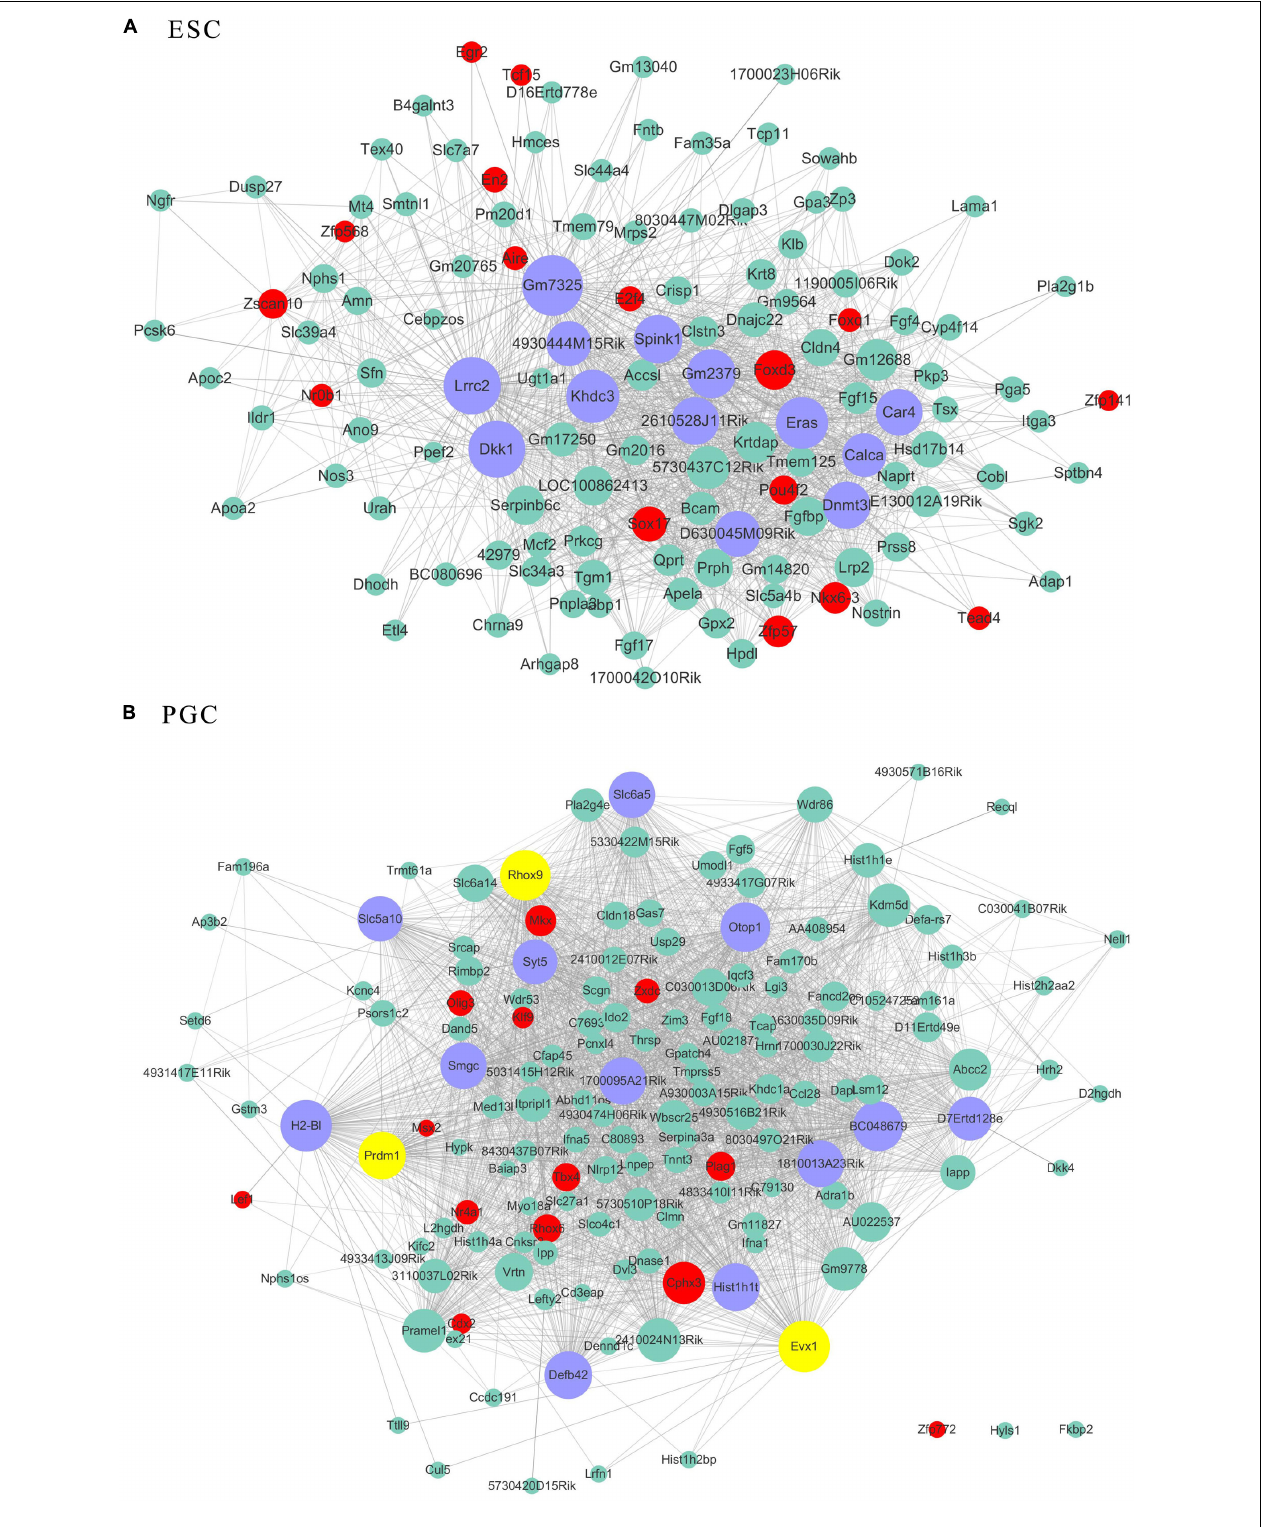
FIGURE 4 | The related co-expression networks of ESC and PGC. The co-expression networks of the ESC-correlated purple module (A) , PGC-correlated brown module (B) . The hub nodes are highlighted in blue within the co-expression networks. Transcription factors within the respective network are highlighted in red. Transcription factors that were included in the top 10% of nodes are highlighted in yellow within the respective networks. The size of the nodes corresponds to their degrees.